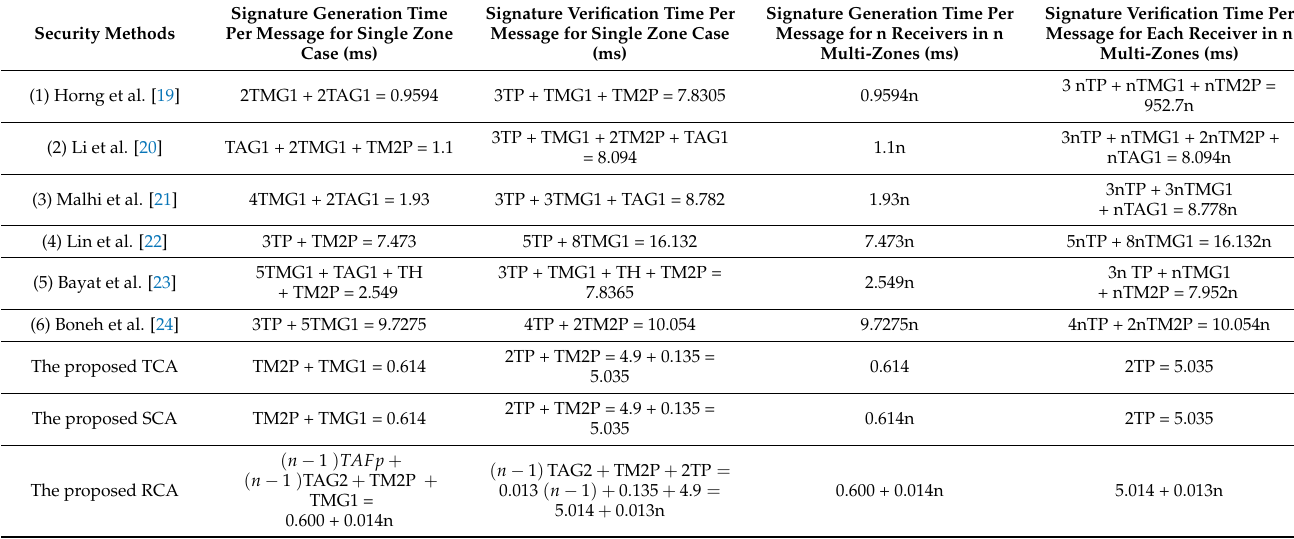
Table 5. A comparison of signature generation time and verification time for the proposed authentication methods and the previous methods in single-zone and multi-zone